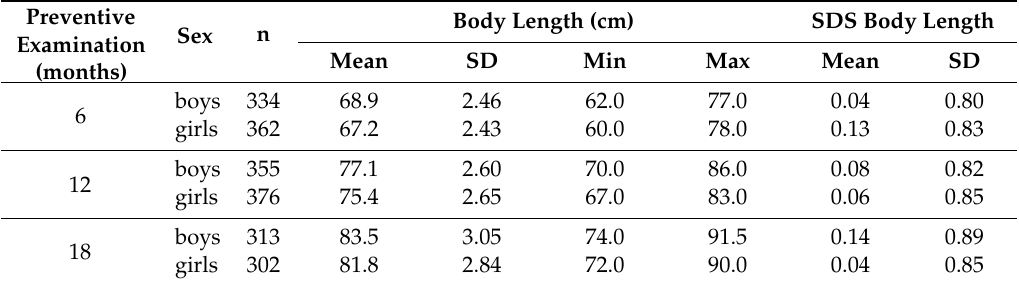
Table 2. The mean body length and mean SDS of body length at 6, 12, and 18 months in children breastfed for 6 months.